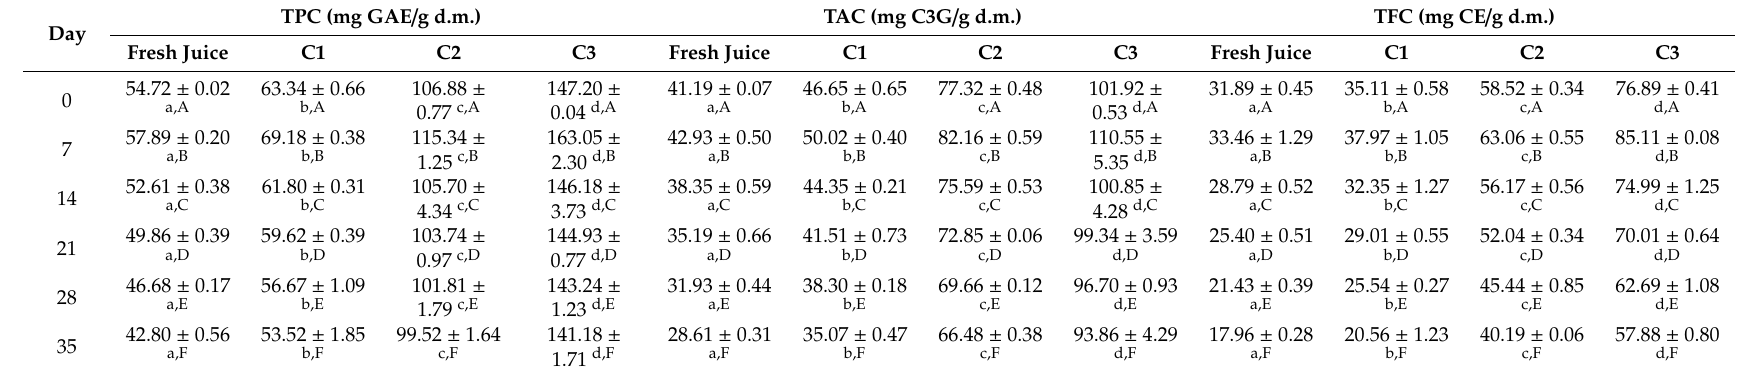
Table 4. Total bioactive compounds (TBC) values of fresh calafate juice and cryoconcentrates during 35 days of